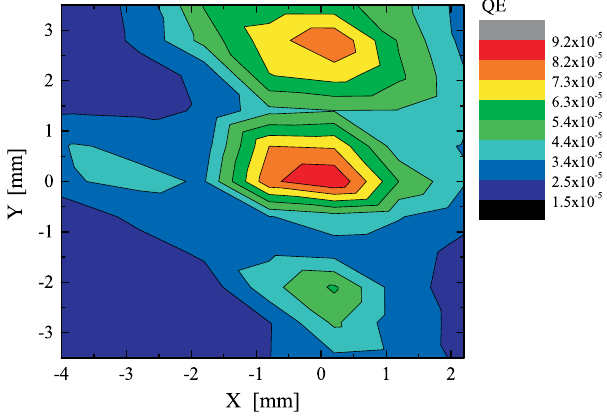
FIG. 6. Plot of QE across the surface after the final laser cleaning with an energy density of 0 : 23 mJ = mm 2 .